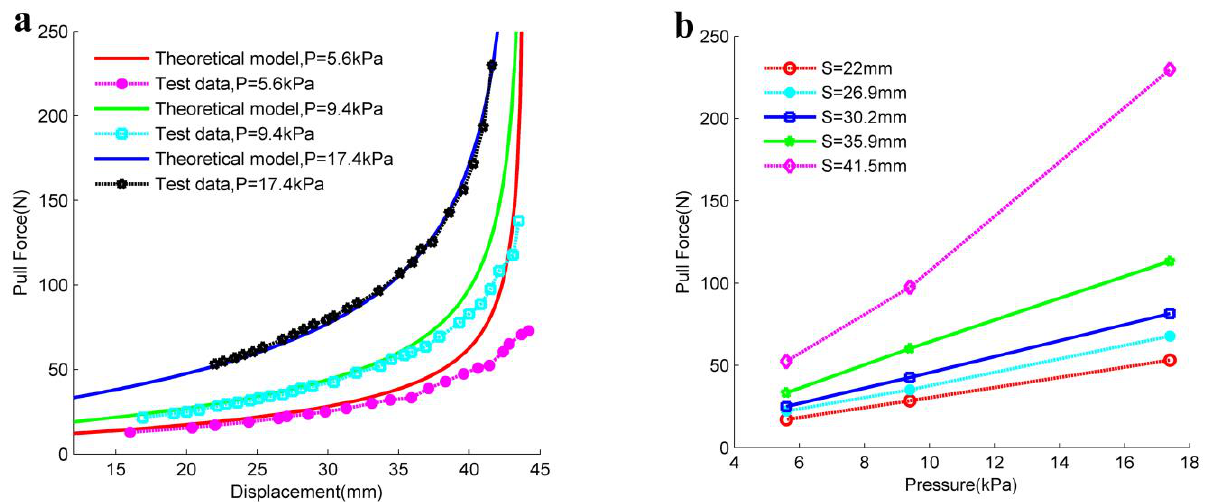
Figure 7. Test results of the actuator with a patched skeleton: ( a ) Force-displacement data; ( b ) Force- pressure data.